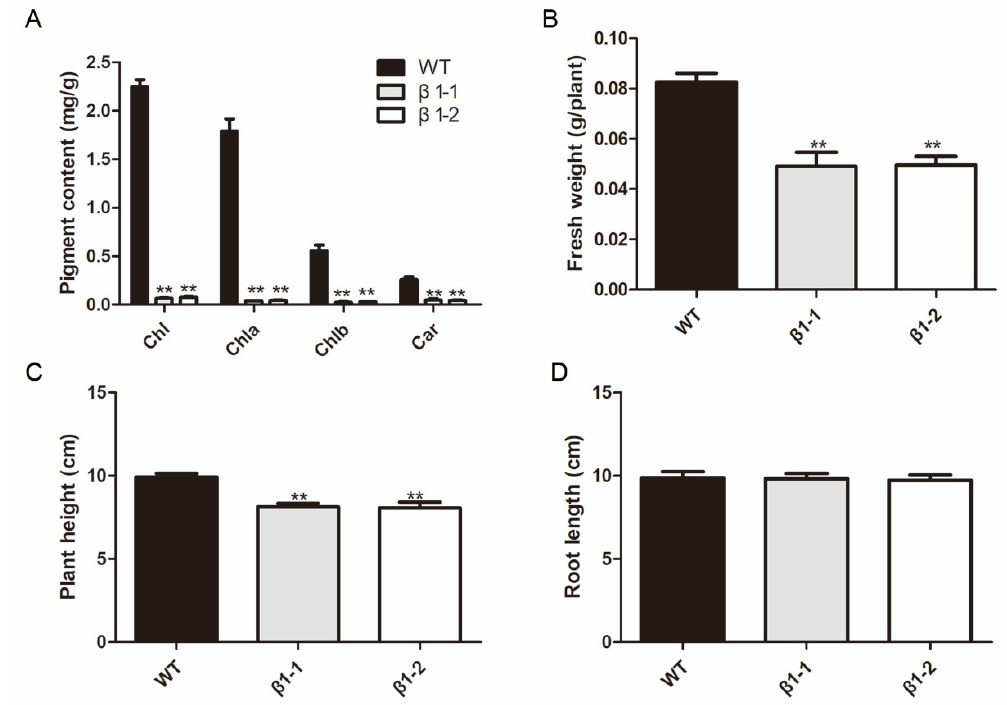
Figure 2. Characteristics of OsCpn60 β 1 mutants at 7-day-old seedling stage. ( A ) Pigment content of wild type (WT) and OsCpn60 β 1 mutant. Chlorophyll a (Chla), chlorophyll b (Chlb), total chlorophyll (Chl) and carotenoid (Car). ( B ) Fresh weight of WT and OsCpn60 β 1 mutants. ( C ) Plant height of wild type and OsCpn60 β 1 mutant. ( D ) Root length of WT and OsCpn60 β 1 mutants. The data are mean ± SD (n = 3) and ** indicates statistical significance at p < 0.01.